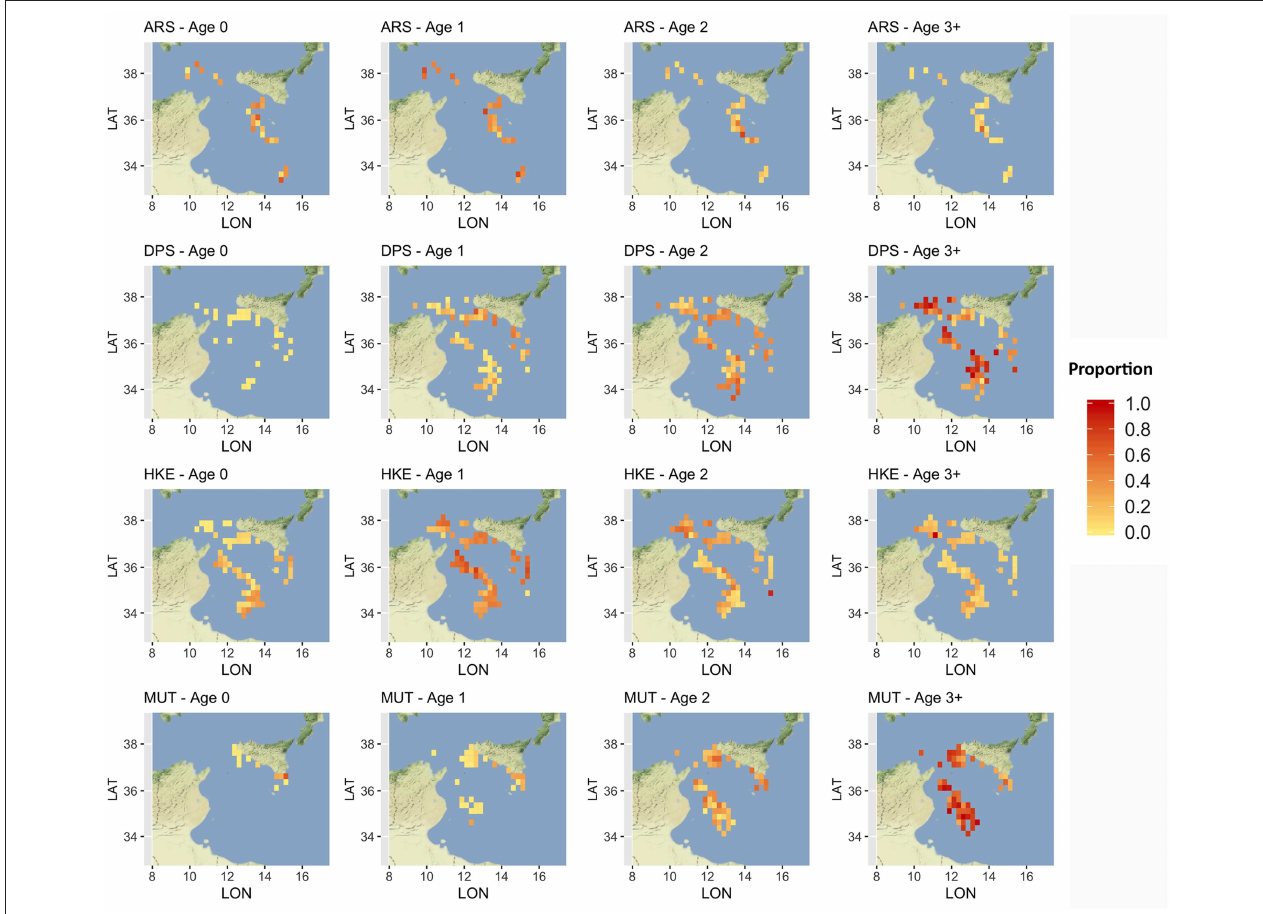
FIGURE 6 | Distribution of the main different age classes, by species, in terms of proportion of landings. Age classes older than 3 years were aggregated to reduce the number of submaps. Figures were created using the R package ggmap (Kahle and Wickham, 2013) using Map tiles by Stamen Design, under CC BY 3.0 and data by OpenStreetMap contributors